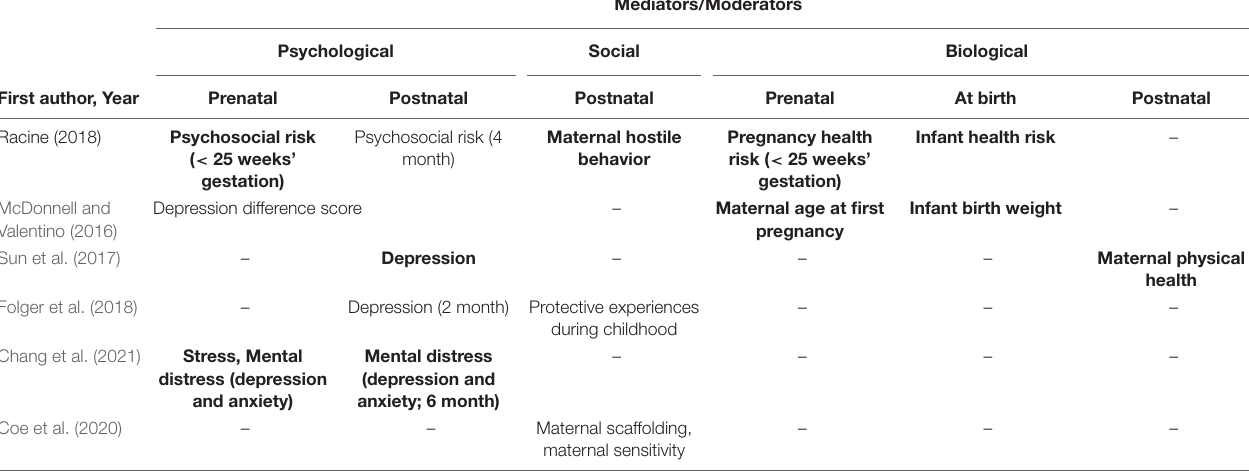
TABLE 2 | Indirect effect of reviewed